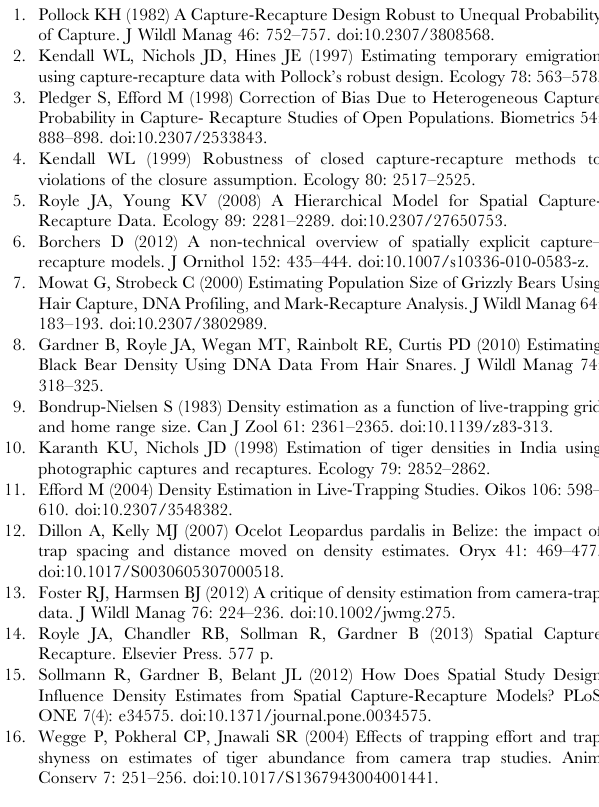
Table S8 in File S1. For s = 5 km, summary of estimates of in the regular, clustered and sequential trap configurations when trap spacing increased from 4.71 to 9.60 km (J =128 to 32 traps) and N= 500. Table S9 in File S1. For s = 10 km, summary of estimates of in the regular, clustered and sequential trap configurations when trap spacing increased from 4.71 to 9.60 km (J= 128 to 32 traps) and N=